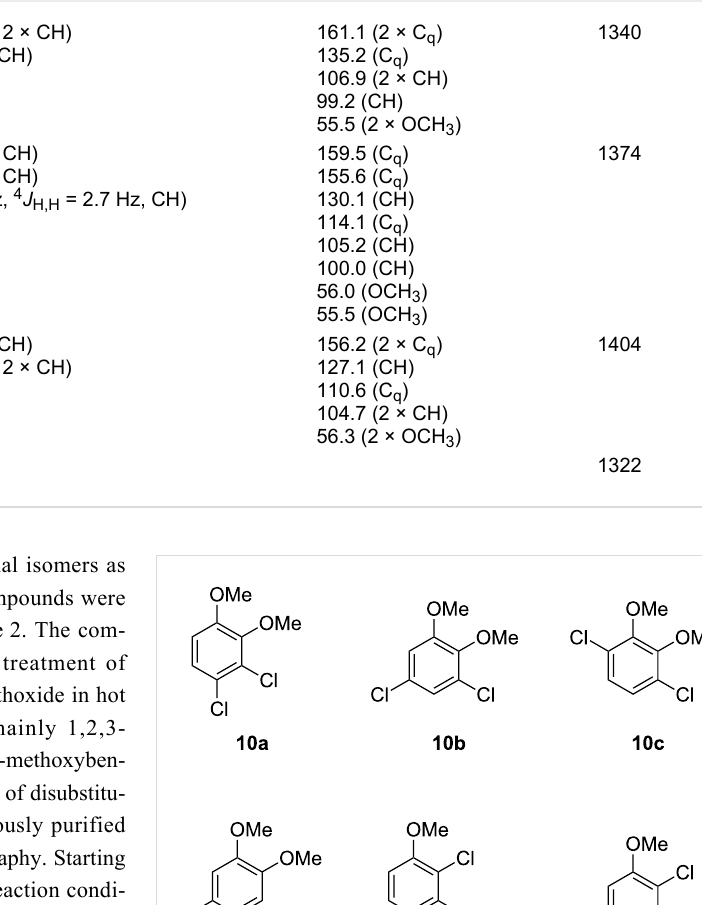
Table 2: NMR spectroscopic data and GC retention indices of all constitutional isomers of chlorodimethoxybenzene in comparison to natural X . (continued)